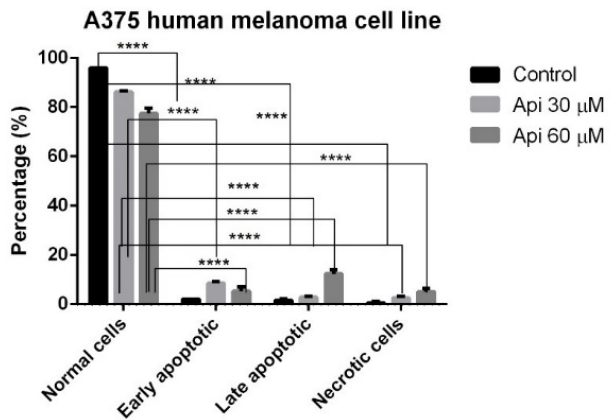
Figure 5. Annexin-PI staining in A375 human melanoma cells incubated with Api 30 µ M and Api 60 µ M, showing the populations of normal, early apoptotic, late apoptotic and necrotic cells. **** p <